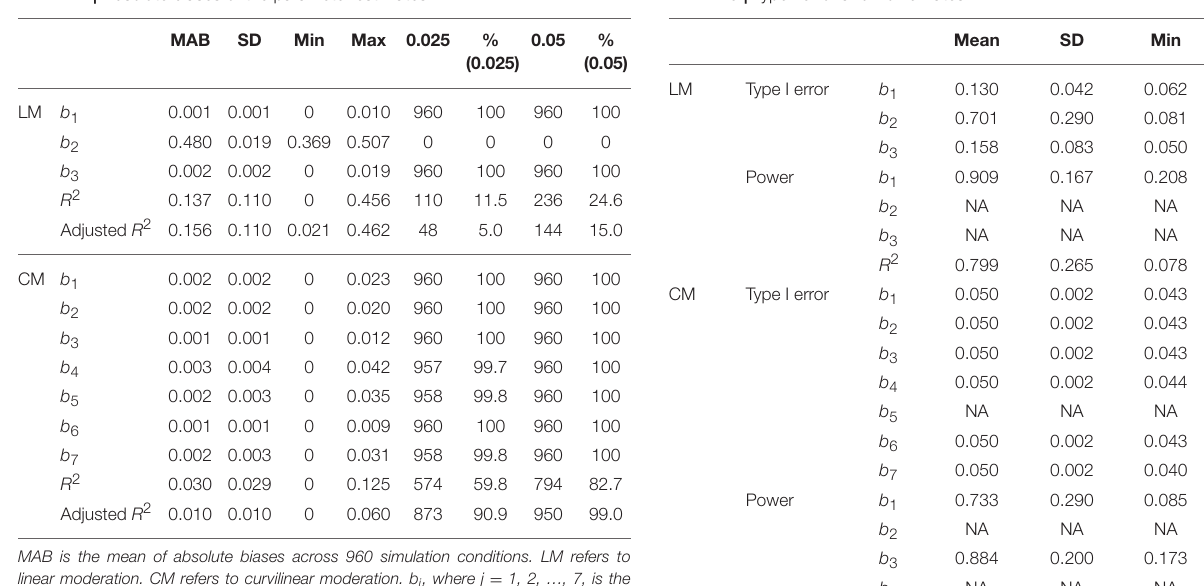
TABLE 2 | Absolute biases of the parameter estimates. TABLE 3 | Type I error and Power rates.